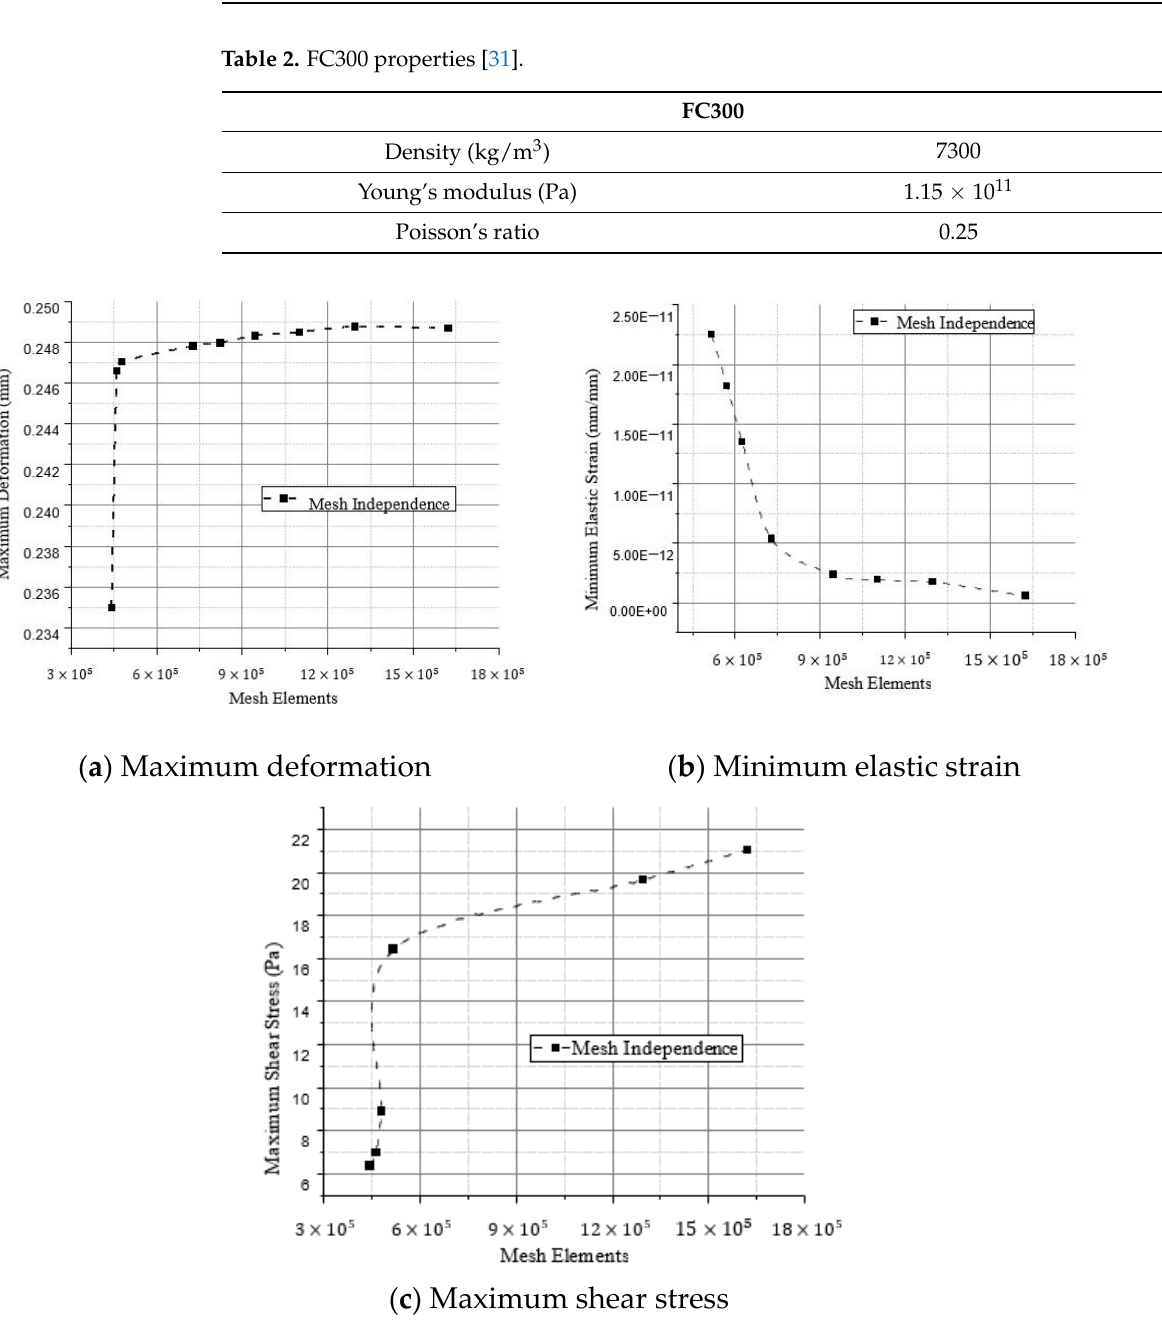
Figure 2. The mesh convergence test results of the fi nite element model.